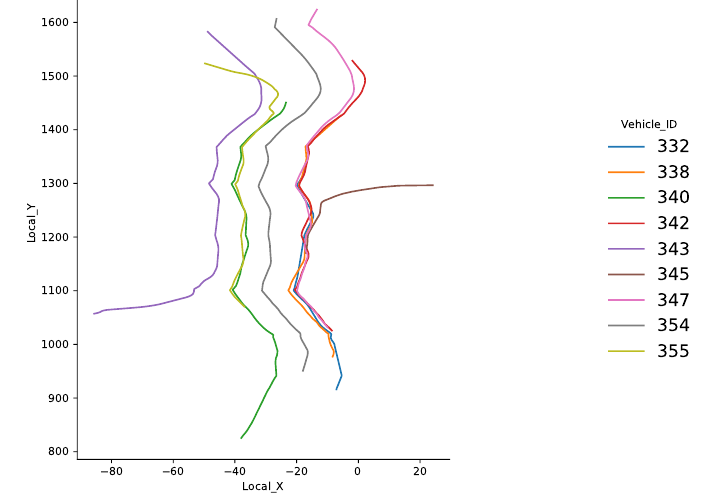
Figure 9. Sample trajectories from the NGSIM data